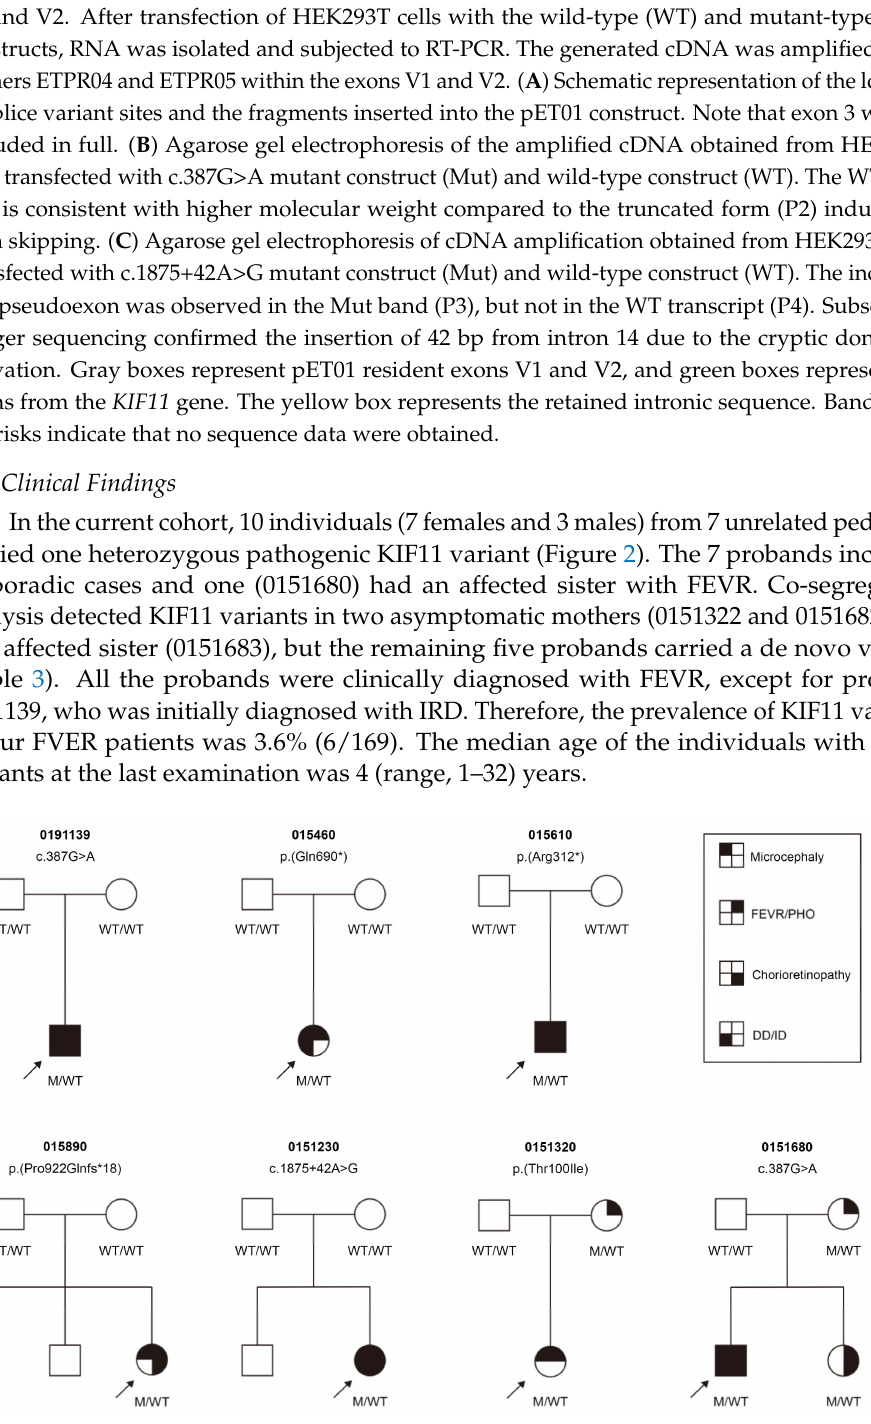
Figure 2. Pedigrees and phenotypes of families with mutations in the KIF11 gene. DD, Development delay; FEVR, familial exudative vitreoretinopathy; ID, Intellectual disability; M, mutant-type; PHO, posterior hyaloidal organization; WT,